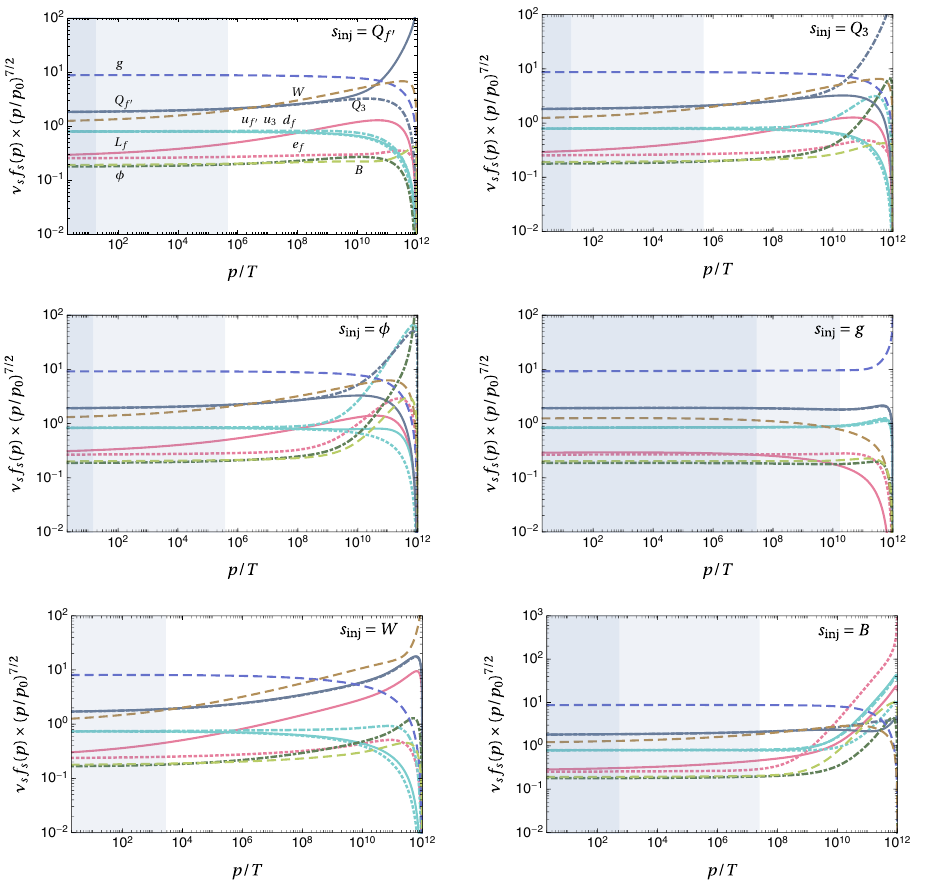
Figure 4 . Same as figure 3, but the primary particle is injected solely for Q f 0 (upper left), Q 3 (upper right), φ (middle left), g (middle right), W (lower left), and B (lower right).